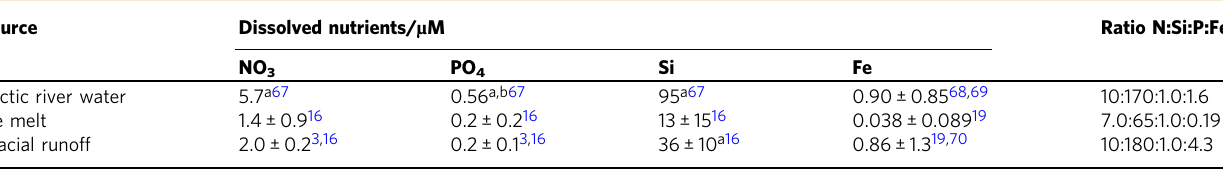
Table 1 Arctic and glacial freshwater composition. Mean (±SD) freshwater nutrient composition in Arctic ice melt, glacial runoff, and river water